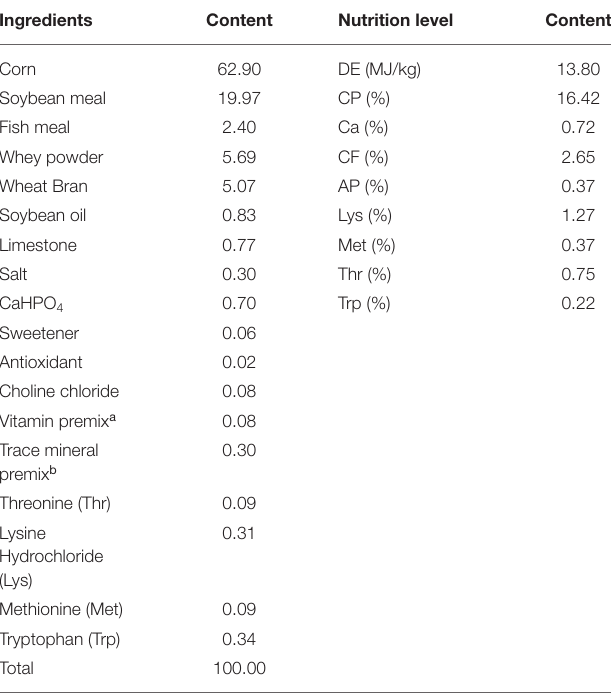
TABLE 1 | The ingredients and nutritional levels of diets (DM basis, %).